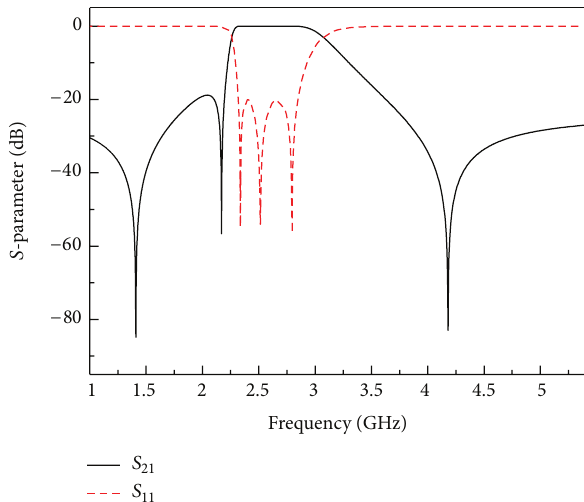
Figure 5: The comparison of frequency responses between triple- mode BPF and dual-mode